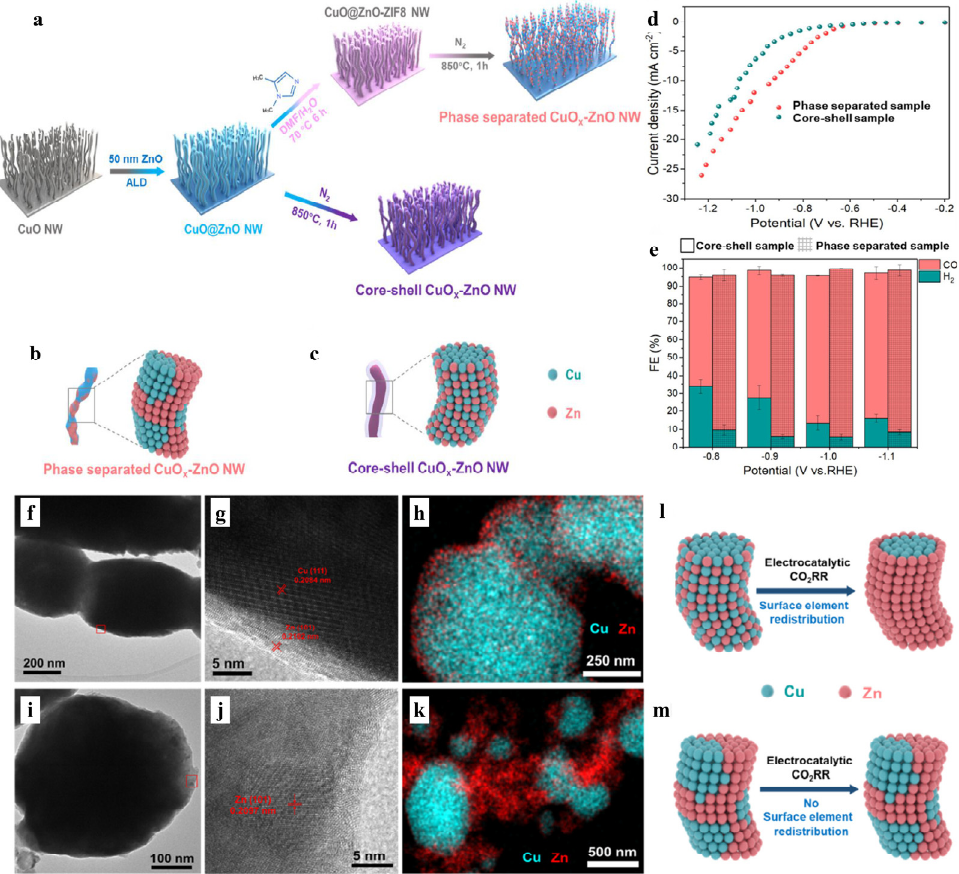
Figure 7. ( a ) Illustration of the synthesis process of phase-separated and core-shell CuO x –ZnO NWs. ( b , c ) Schematic diagrams of phase-separated and core-shell samples in microscale (only metal elements are shown for a simplified and clarified illustration). Electrochemical CO 2 reduction performance. ( d ) Linear sweep voltammetry curves of phase-separated and core-shell samples in CO 2 -saturated 0.1 M KHCO 3 solution. ( e ) FE of main products of core-shell and phase-separated samples. ( f ) Low resolution TEM image of the core-shell sample after 20 min electrocatalytic CO 2 RR, ( g ) HR-TEM image of the red square part in ( f ). ( h ) EDX mapping of the core-shell sample. ( i ) TEM image of the phase-separated sample after 20 min electrocatalytic CO 2 RR. ( j ) HR-TEM image of the red square part in ( i ). ( k ) EDX mapping of the phase-separated sample. ( l ) Element redistribution of core-shell and ( m ) phase-separated samples [93]. Reproduced from Ref. [93] with permission. Copyright © 2023, American Chemical Society.